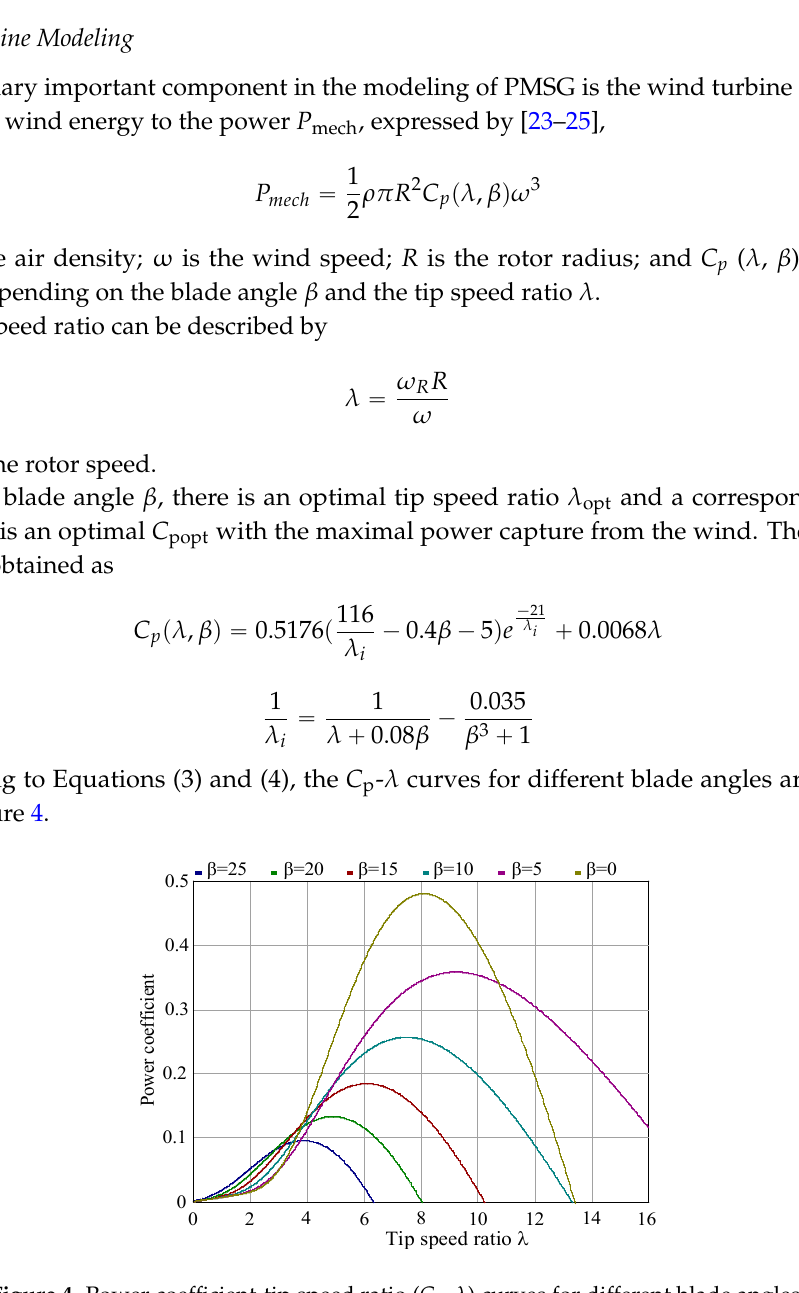
Figure 3. Wiring scheme of the new grid ‐ connected transformer.